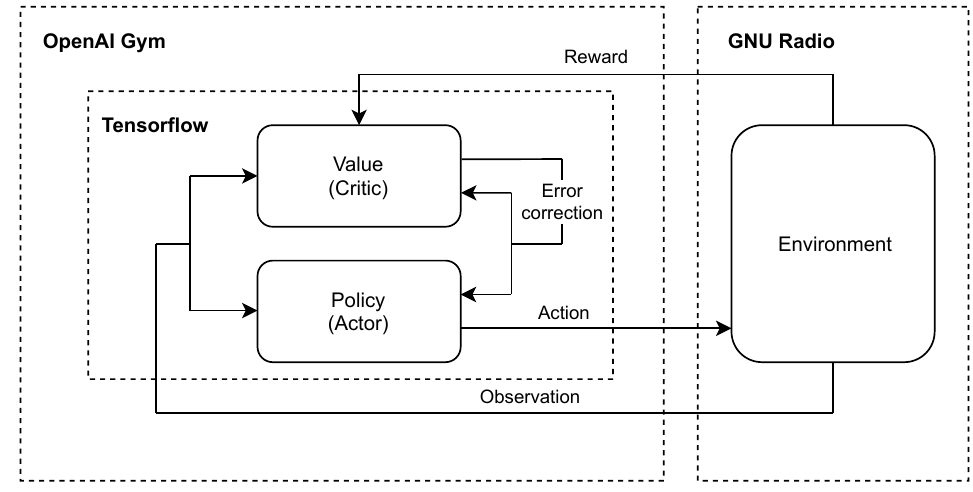
Figure 1. Actor-critic reinforcement learning approach with used